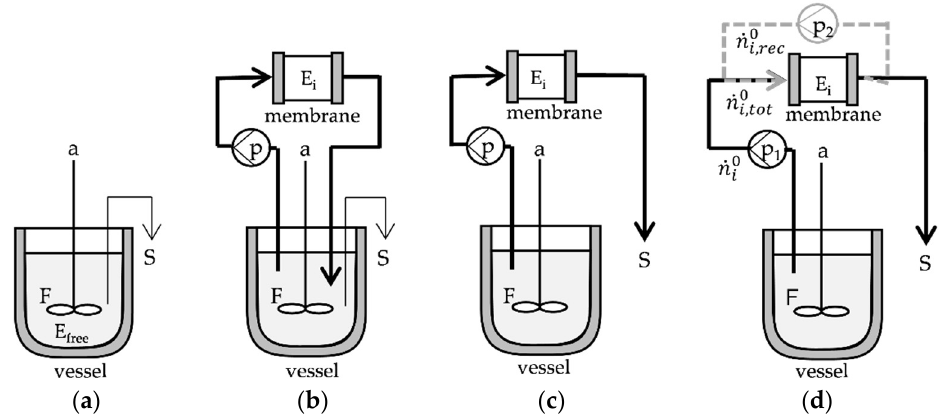
Figure 2. Reactor configurations for GOS synthesis: ( a ) discontinuous (batch) reactor with free enzyme (E free ) and ( b ) semi-continuous, ( c ) continuous ( d ) continuous with recirculation with immobilized (E i ) enzyme on monolithic PTFR (disk or 1 mL, 8 mL, 80 mL); F: feed stock solution (lactose), a: agitation, S: sampling, p: pump, n: amount of substance.